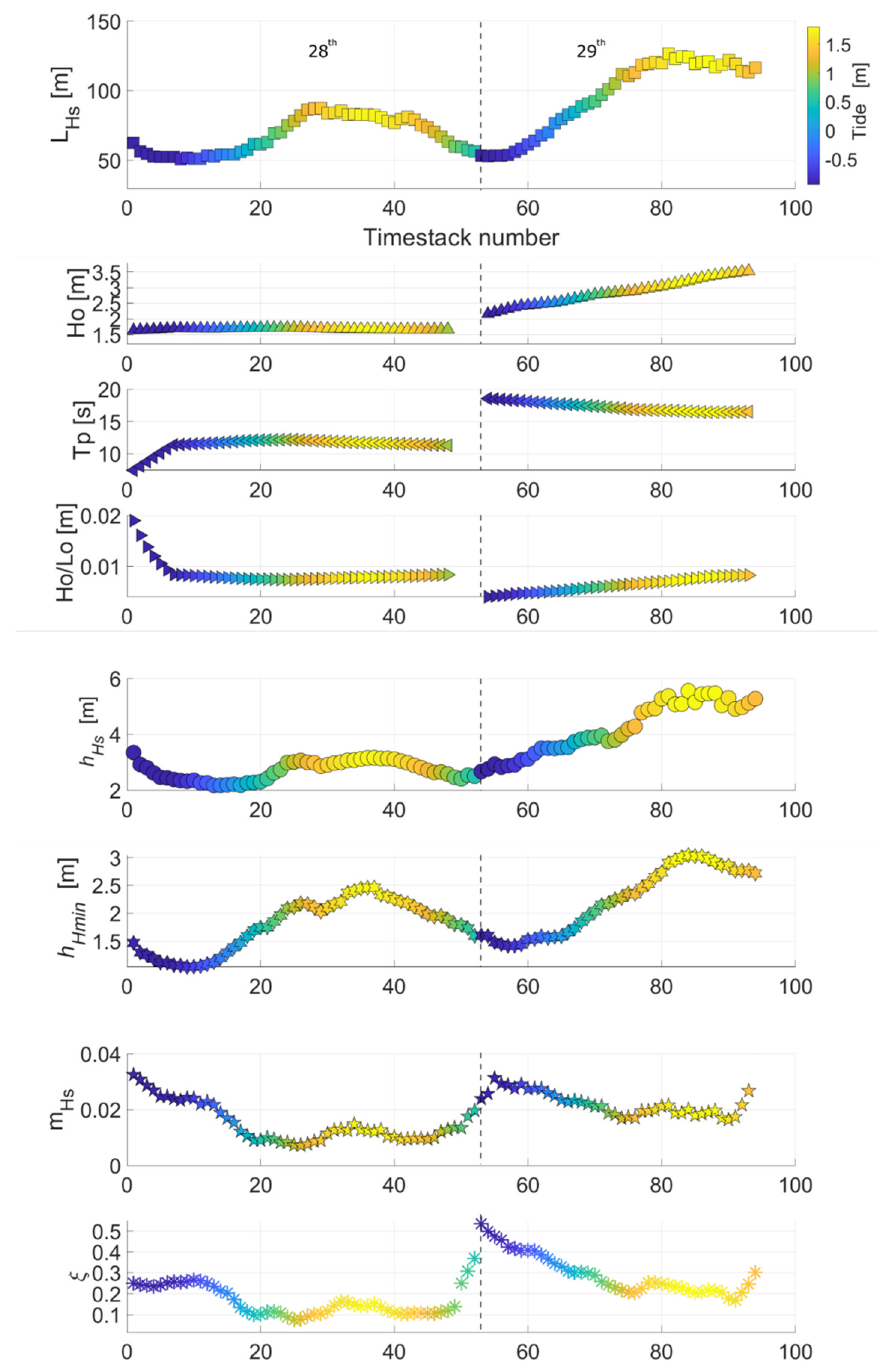
Figure 6. Wave breaking parameters derived from video imagery to solve Equation (9). L Hs records (squares) versus o ff shore significant wave height H o , wave period T P , and wave steepness H o / L o (triangles); water depth h b , Hs (circles) and h b , Hmin (hexagons); beach slope m Hs (pentagrams); and Iribarren number ξ (stars). Vertical black dashed line divides data from 28 March ( left ) and 29 March ( right ). The x-axis is common to all plots and indicates Timestack number (1–52 for 28 March and 53–94 for 29 March).